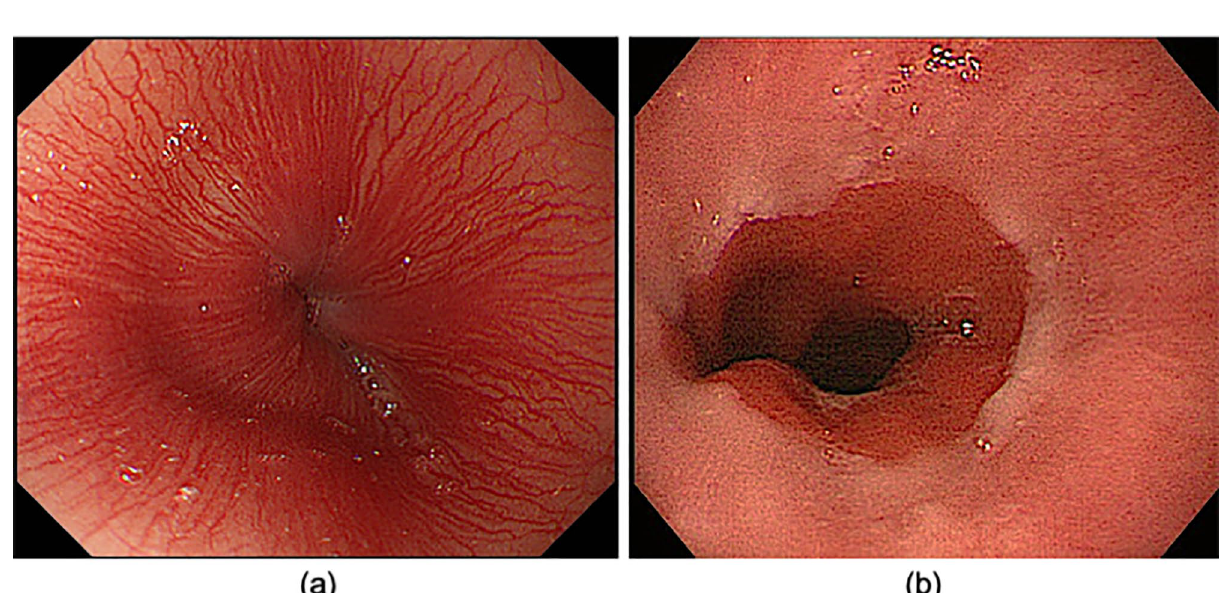
Figure 6. Typical endoscopic images of LA grades N and M. ( a ) LA grade N = no endoscopic changes in esophageal mucosa. ( b ) LA grade M = endoscopic appearance of discoloration of the esophageal